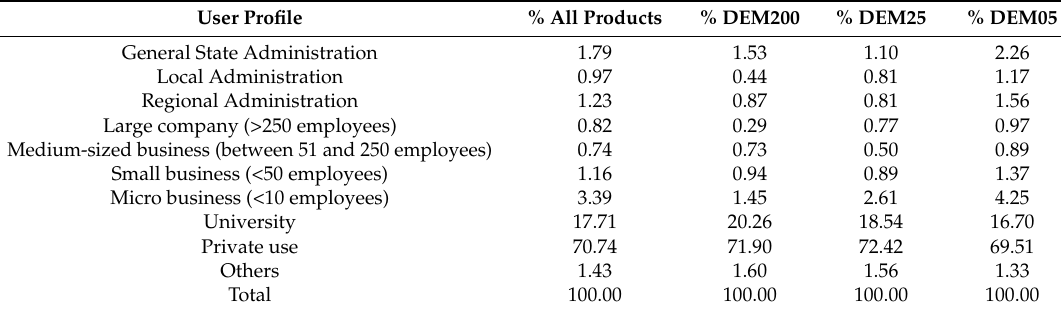
Table 4. Downloads by user